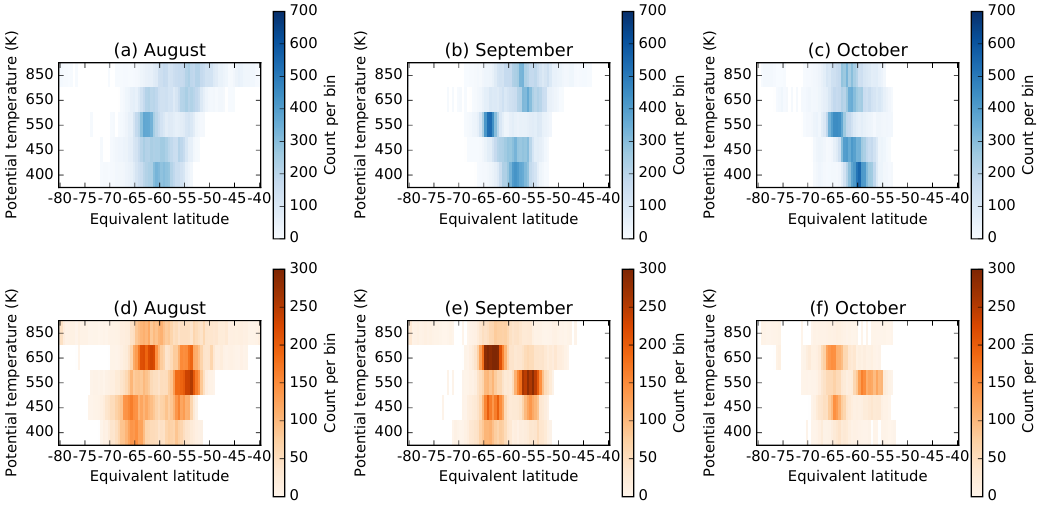
Figure 8. Locations of (a–c) primary and (d–f) secondary peaks in PV gradient at CFSR levels between 400 and 850K, 1979–2016. Peaks are selected using a minimum separation of 5 ◦ and the colour scale shows the number of times that peaks occurred in each 0.5 ◦ bin.